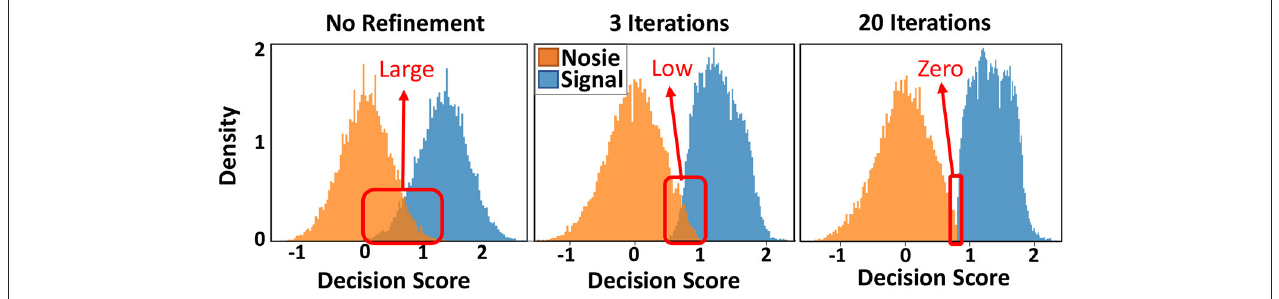
FIGURE 9 | Distribution of existing and non-existing nodes in graph memory without and with an iterative graph memory refinement, shown for 100,000 edges.